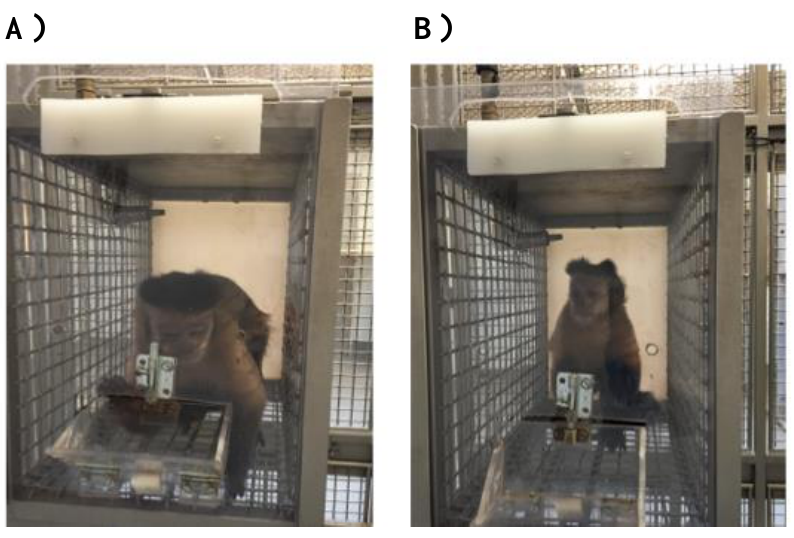
Figure 1 ( A) Self-control accumulation task set-up. Food pan unlocked so monkey and experimenter can access its contents (used in Free Accumulation condition). B) Self-control accumulation task set-up. Food pan locked so monkey cannot access